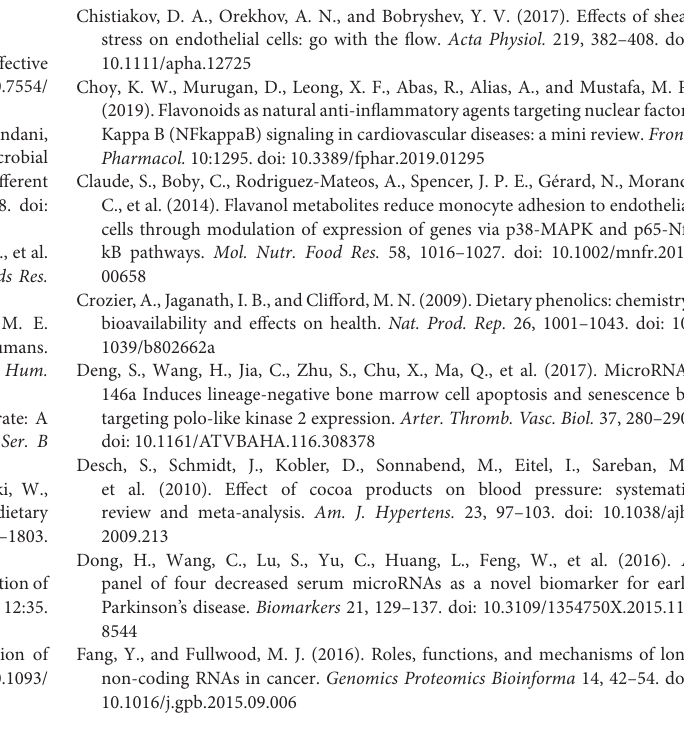
Supplementary Figure 1 | Chemical structures of microbiota epicatechin metabolites. Supplementary Figure 2 | miRNA-enriched pathway interactions network. Pathway interactions network built in Cytoscape software to show the connections (edges) between enriched pathways (nodes) by miRNAs differentially expressed. Supplementary Figure 3 | Venn diagrams of mRNAs, miRNAs targets, lncRNAs targets, proteins and pathways related in human brain microvascular endothelial cells- γ -valerolactone treatment cell. (A) Venn diagram indicates the relationships between the number of mRNAs, miRNAs targets, lncRNA targets, and proteins differentially expressed. (B) Venn diagram indicates the relationships between the number of enriched pathways-mRNAs, miRNAs targets, lncRNA targets and proteins differentially expressed. Supplementary Table 1 | Effect of the γ -Valerolactones treatment on the expression of protein-coding genes in human brain microvascular endothelial cells: mRNAs differentially expressed. Supplementary Table 2 | Effect of the γ -Valerolactones treatment on the expression of miRNAs in human brain microvascular endothelial cells: miRNAs differentially expressed. Supplementary Table 3 | Effect of the γ -Valerolactones treatment on the expression of lncRNAs in human brain microvascular endothelial cells: lncRNAs differentially